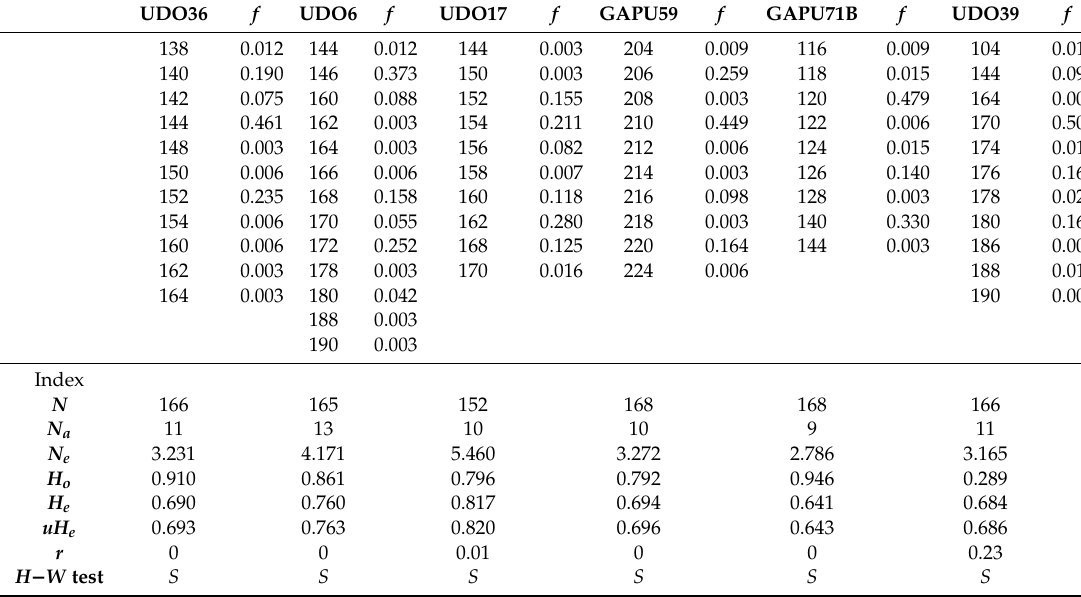
Table 2. Genetic indexes calculated with the GenAlex software. Allelic frequency ( f ), number of amplified DNA samples ( N ), number of di ff erent alleles ( N a ), e ff ective number of alleles ( N e ), frequency of the null allele ( r ), observed ( H o ) and expected ( H e ) heterozygosity, weighed expected heterozygosity ( uH e ) and probability of the exact Hardy–Weinberg test ( p -value < 0.001, S : significant, NS : not